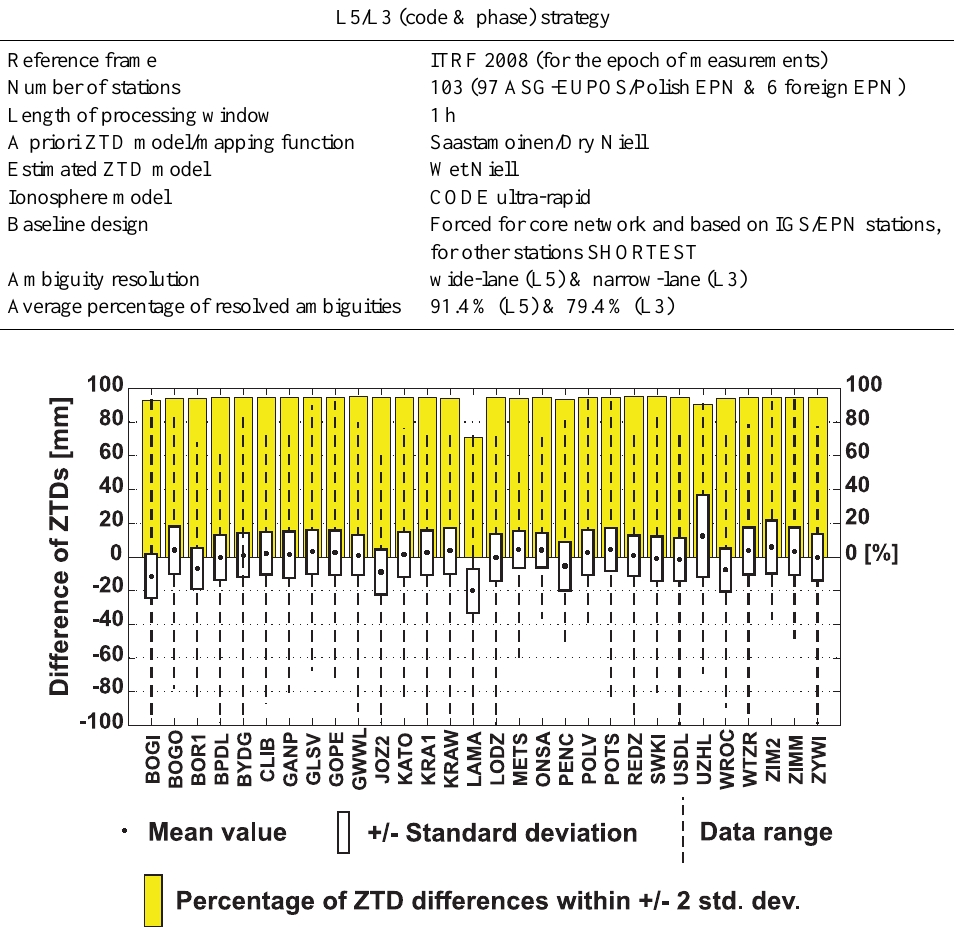
Fig. 8. Comparison statistics of estimated NRT ZTDs for 30 EPN stations with EPN combined weekly solution for a period of 120 days in